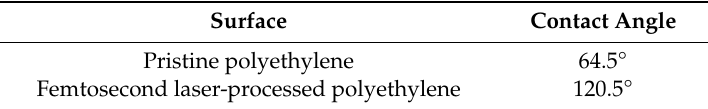
Figure 1. Environmental scanning electron micrograph of a pristine PE surface ( a ) and the corresponding femtosecond laser-processed PE surface ( b ). Table 1. Averaged contact angles of water on pristine and laser-modified PE surfaces. In both cases, the standard deviation of the contact angle was below 2° (number of measurements ≥ 12).